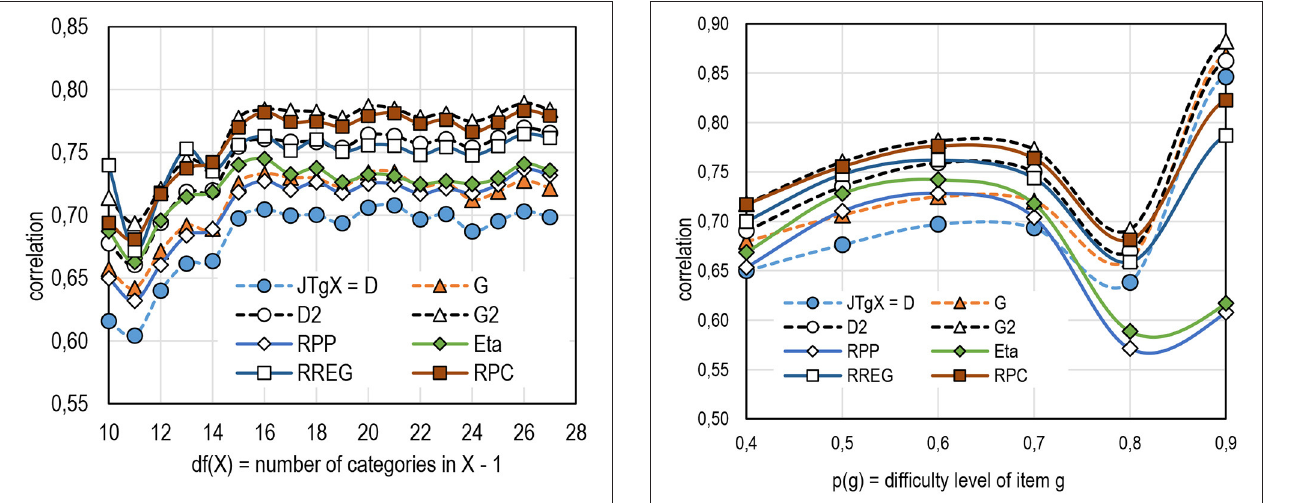
FIGURE 4 | Average estimates by the number of categories in the score (k = 6,932 items). FIGURE 5 | Average estimates by the item difficulty (k = 6,932